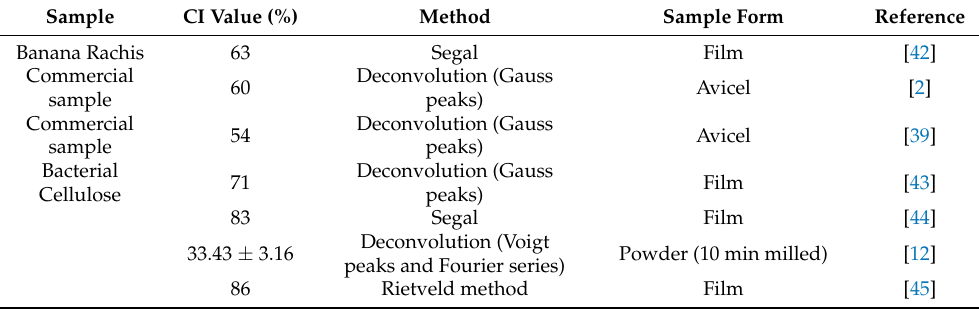
Table 5. Reference values of cellulose